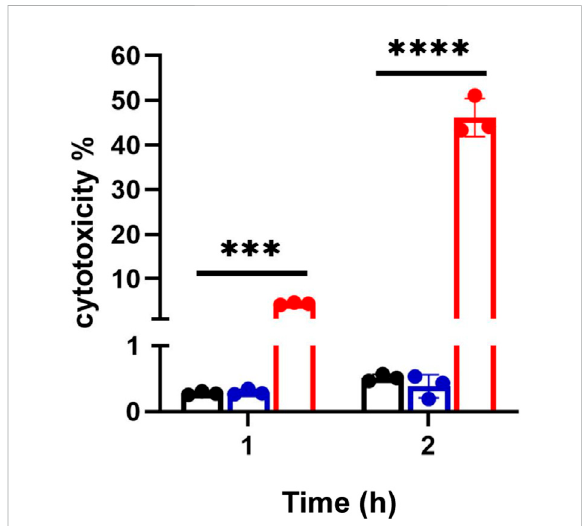
FIGURE 3 Bacteria mediated endothelial cell death. EA cells were exposed to either CFT073 (red) or JM109 (blue) at EA: E. coli cell ratio of 1:20 for indicated times at 37 ° C. At the end of incubation, media were collected and LDH assay was performed as described in “ Materials and Methods ” . Statistics were performed usingonewayANOVA, n =3, p value:**** p < 0.0001,*** p <